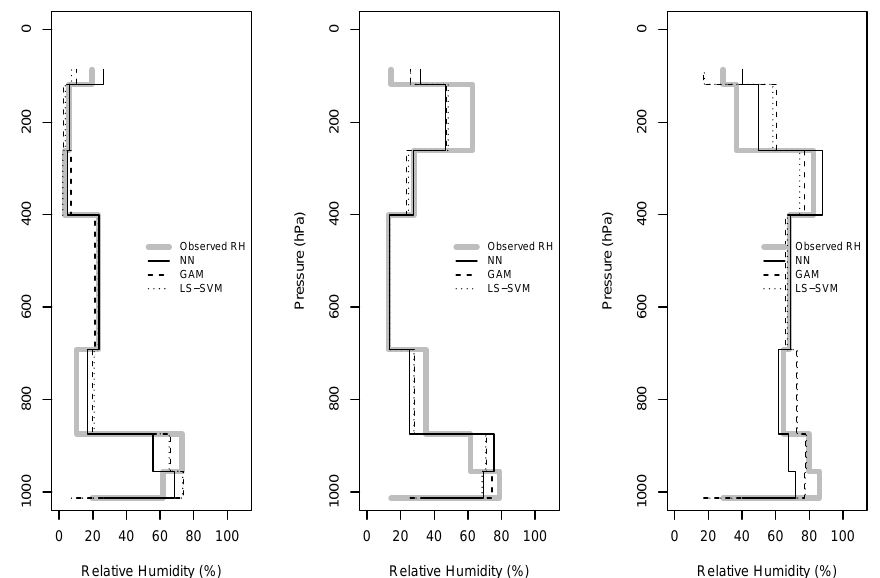
Figure 4. Examples of three estimations of RH profiles (in %RH) extracted from the database using the SAPHIR-MADRAS configuration. The observed profile is the thick gray line and the three estimations (plain, dashed, dots, respectively, for MLP, GAM and LS-SVM) are in black.